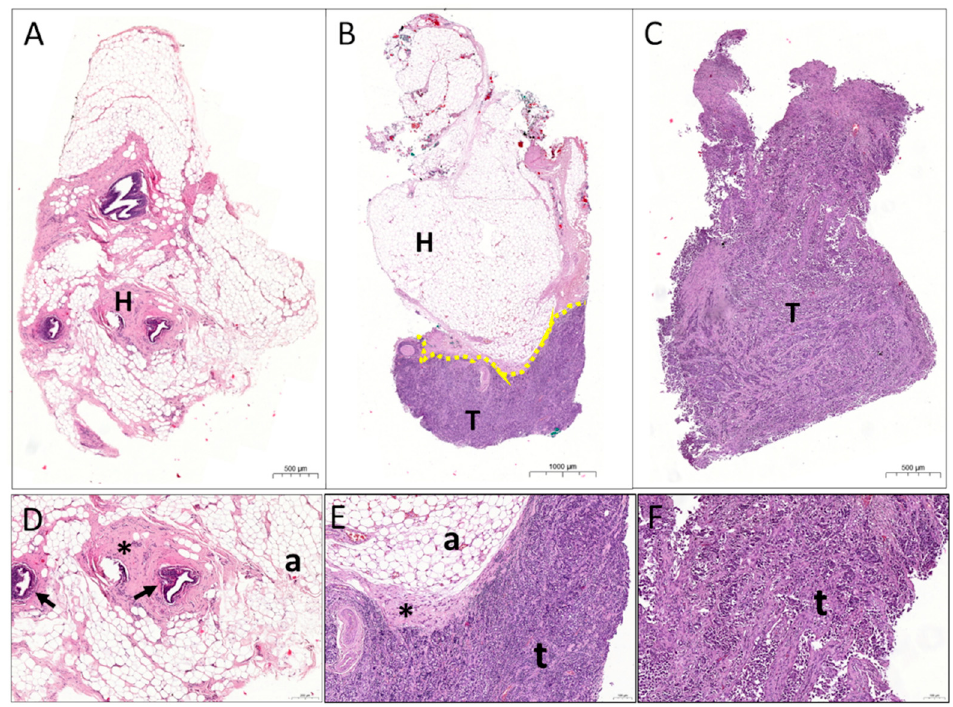
Figure 1. Representative images of healthy ( A ), mix ( B ), and tumour ( C ) breast tissue samples stained by H&E. ( D – F ) magnification of ( A – C ), respectively. Arrows indicate normal mammary ducts, * indicate fibrous tissue, “a” indicate adipocytes, and “t” tumour cells.